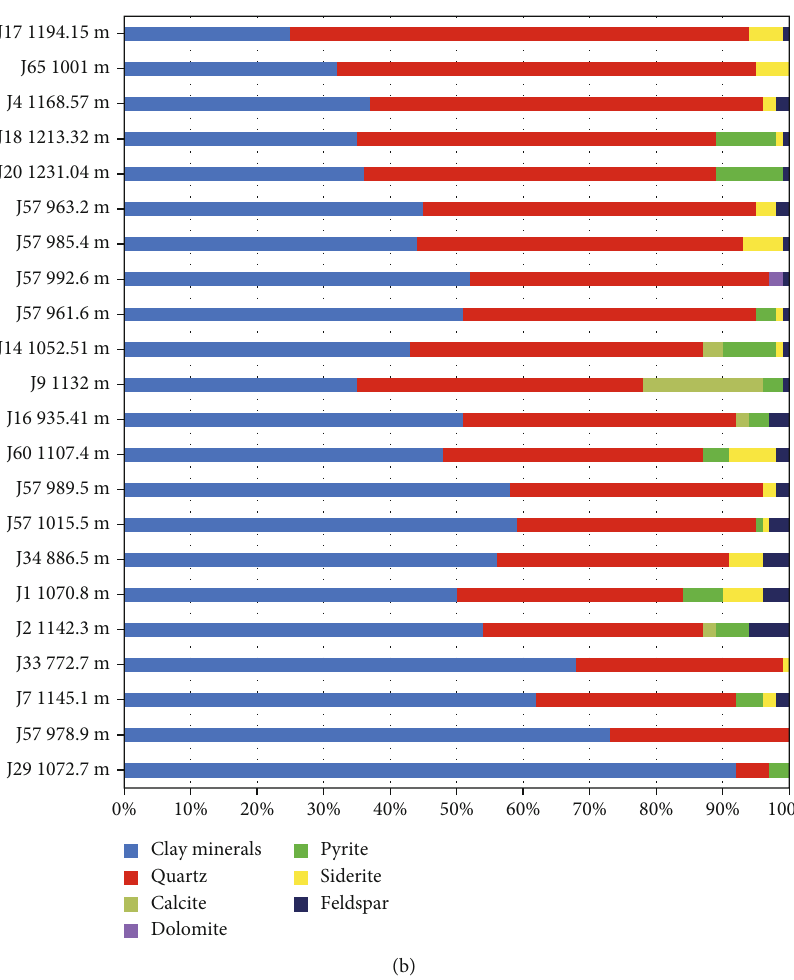
Figure 7: The detrital components of the mud (shale) stone reservoirs in the study area. (a) Shanxi Formation; (b) Taiyuan